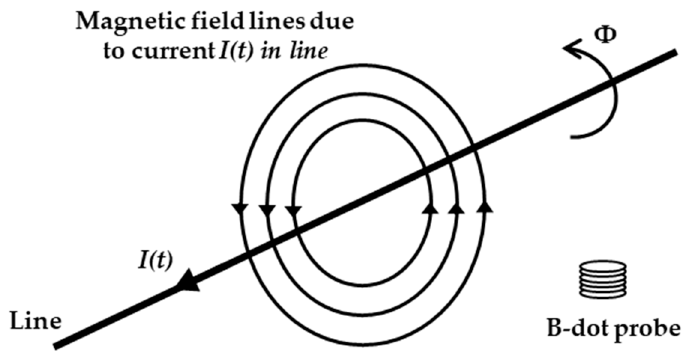
Figure 1. The measurement principle of the B-dot sensor. The current creates a magnetic field and induces an electromotive force in the coil.